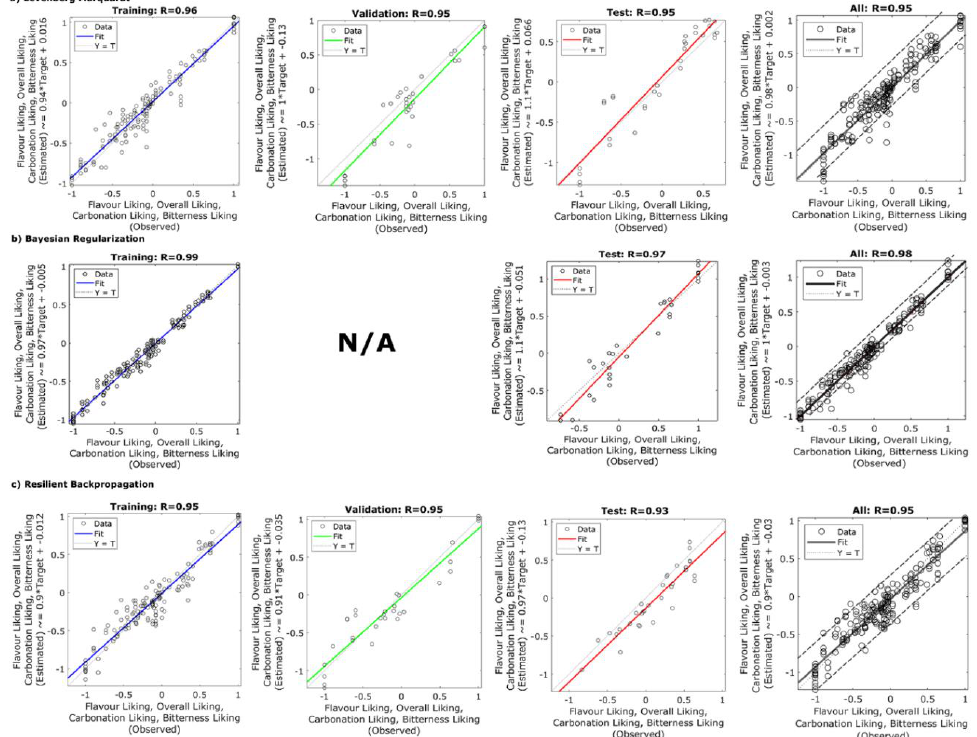
Figure 3. Models showing the three stages (training, validation and testing) as well as overall model of the three best algorithms found to assess liking of beer from morpho-colorimetric parameters from beer and beer foam: ( a ) Levenberg Marquardt, ( b ) Bayesian Regularization and ( c ) Resilient Backpropagation, showing the correlation coefficient (R) and 95% confidence bounds. In all graphs, the x-axis represents the observed data and y-axis the predicted or estimated values. N/A = not applicable.